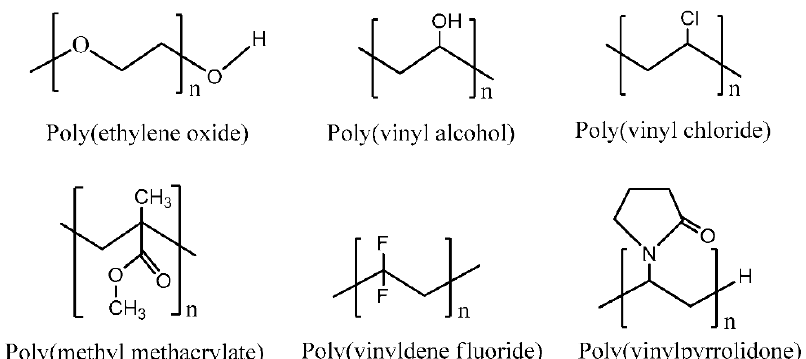
Figure 3. Chemical structure of some polar polymers used as a host polymer.